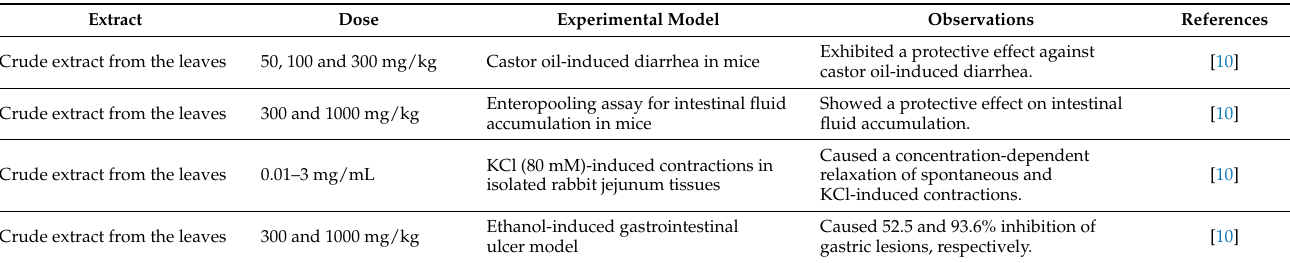
Table 11. The gastrointestinal effects of Ziziphus nummularia